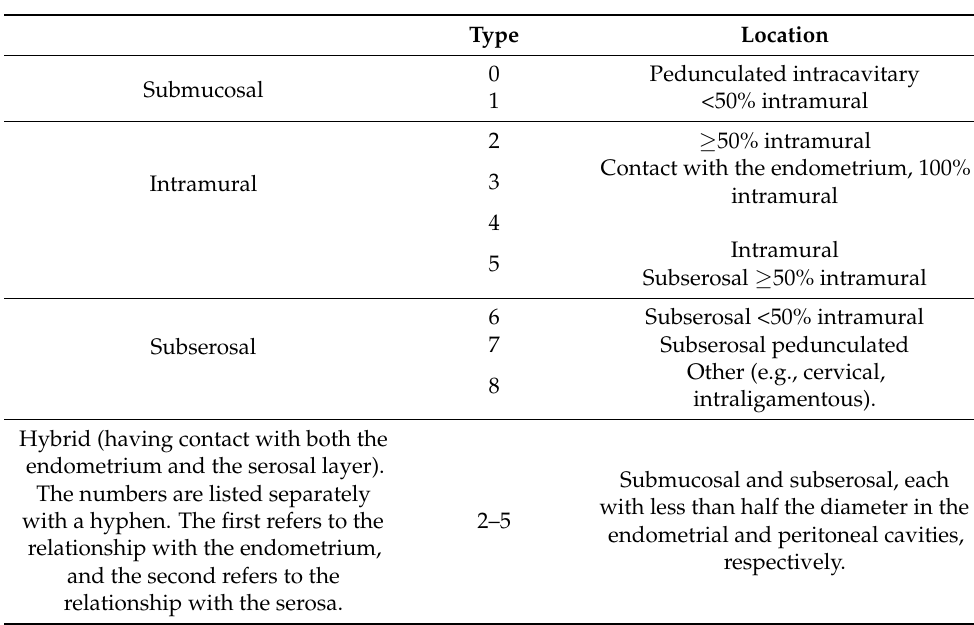
Figure 2. The International Federation of Gynecology and Obstetrics (FIGO) uses the above-depicted classification system of fibroids, organized according to the location between the submucosal, intramural, and subserosal layers of the uterus (modified according to Dr. Sachintha Hapugoda, Radiopaedia, Australia). Table 1. The International Federation of Gynecology and Obstetrics (FIGO) classification of fibroids.